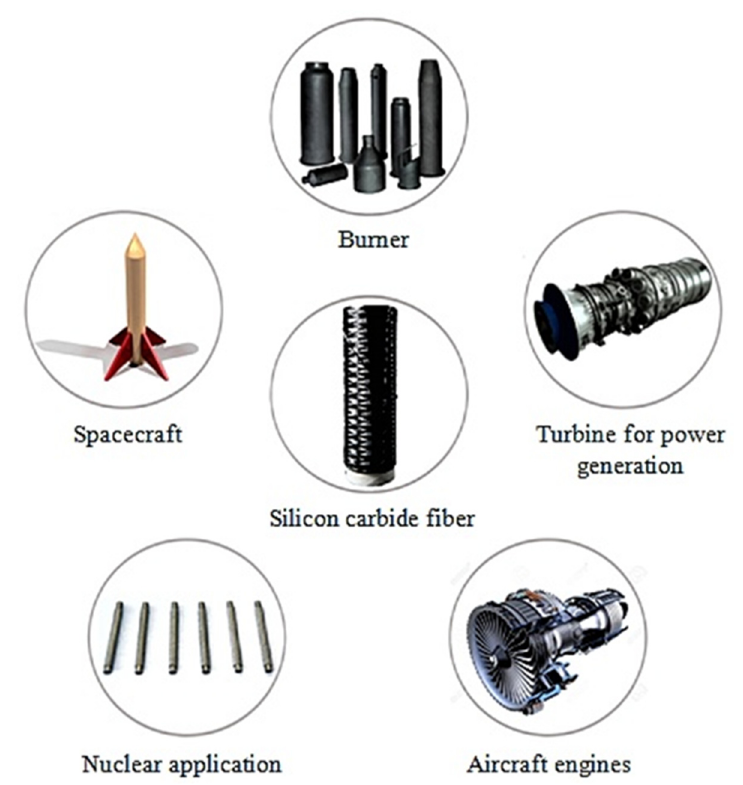
Figure 16. Image showing various applications of silicon carbide.